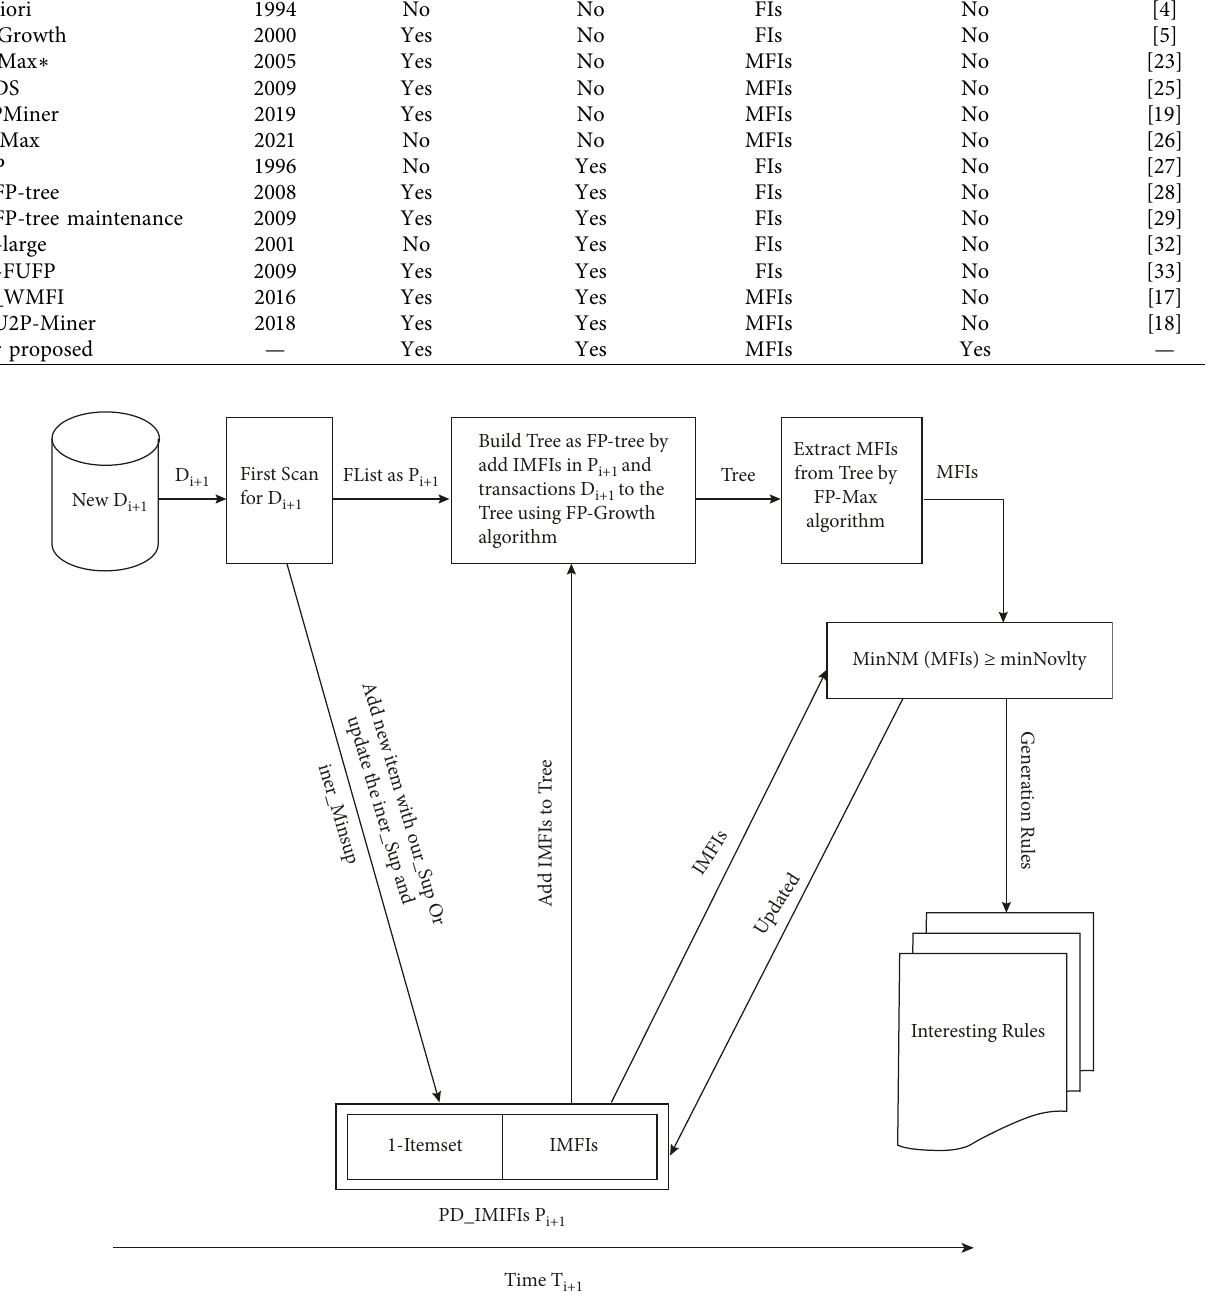
Figure 1: General architecture of the proposed